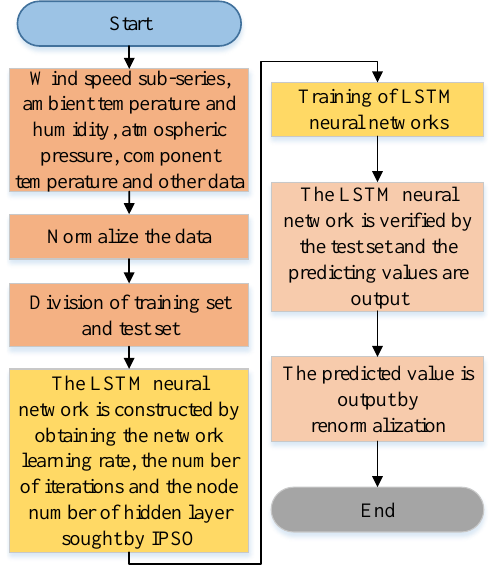
Figure 3. Predicting model based on IPSO – LSTM.